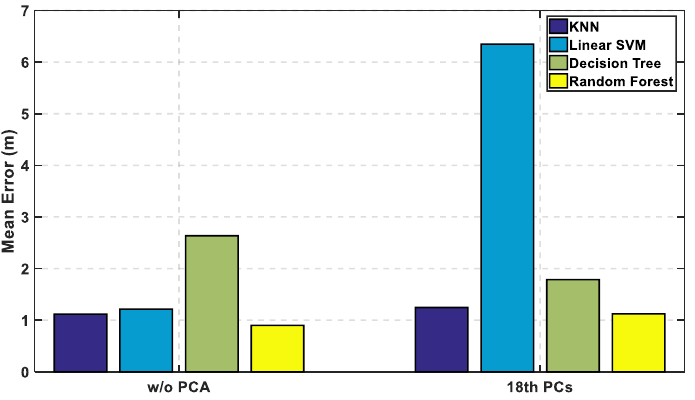
Figure 12. Mean Error Versus the Machine Learning Approach with and without PCA.